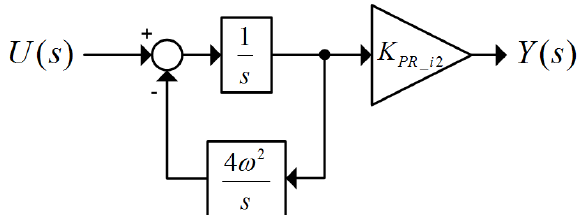
Figure 10. PR controller for harmonic compensation.